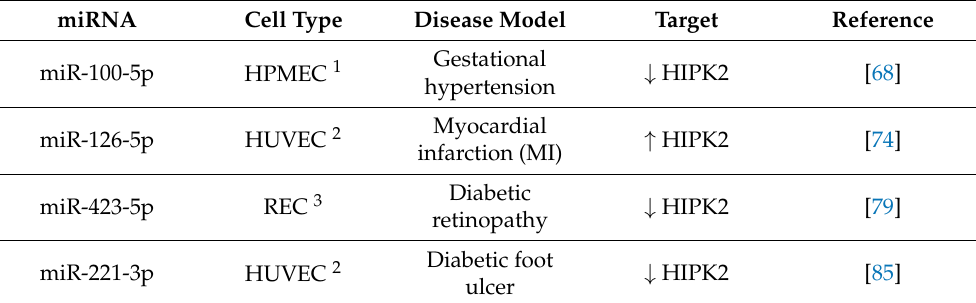
Table 2. Summary of the miRNA/HIPK2 expression described in the reported references. miRNA Cell Type Disease Model Target Reference